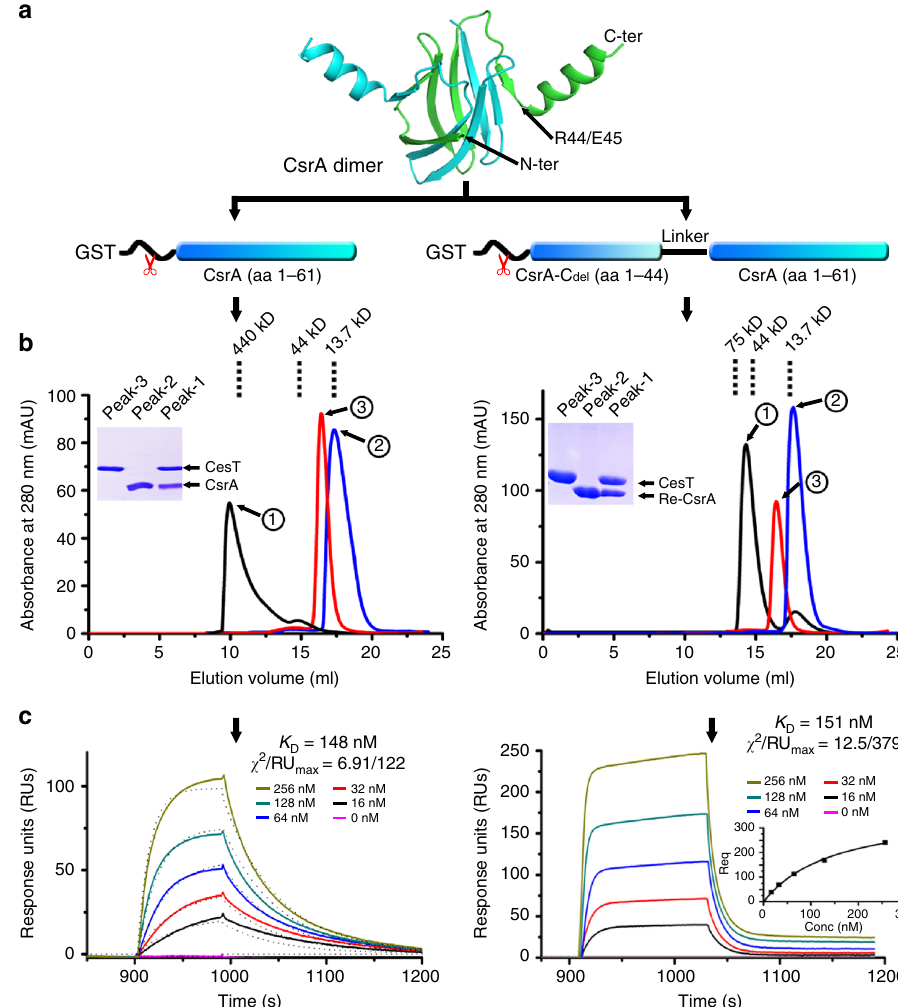
Fig. 1 Biochemical characterization of the bindings for the CesT/CsrA and CesT/Re-CsrA pairs. a A schematic fi gure showing the construction and expression strategies for the native CrsA and Re-CsrA proteins. The native domain-swapped CsrA-dimer structure (PDB code: 2BTI) is shown in cartoon representation to highlight the β -barrel core and the terminal α -helix which are bordered at R44/E45. Re-CsrA is a recombinant CsrA dimer, composed of a C-helix-deleted CsrA (CsrA-C del ) connecting via a linker to a full length CsrA. Both CsrA and Re-CsrA are initially expressed as GST-fusion proteins, which are then enzymatically digested to remove the GST-tags. b Analyses of the CesT/CsrA and CesT/Re-CsrA complexes by analytical gel fi ltration. The 280- nm absorbance curves and the SDS-PAGE migration pro fi les of the indicated proteins are shown. Dashed lines indicate the standard molecular weight markers. c An SPR assay characterizing the real-time binding kinetics of CsrA and Re-CsrA to immobilized CesT. The recorded pro fi les are shown. The af fi nity is calculated using the Bivalent-Analyte model for the native CsrA and the steady-state af fi nity model for Re-CsrA, respectively. The calculated- fi t curve is shown as dashed lines for CsrA and as a built-in panel for Re-CsrA. The goodness of fi t between the experimental data and the model algorithm is also highlighted by the low χ 2 /RU max values